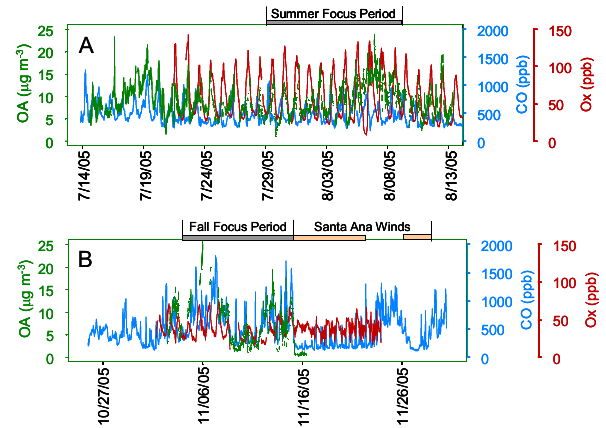
Fig. 5. AMS PM 1 organics, carbon monoxide (CO), and odd oxygen (O x ) concentrations during SOAR 2005. (A) The sum- mer period (29 July–8 August) displays regular diurnal oxidation trends. The summer focus period (outlined in grey) is consistent with the general trend of the entire summer study. (B) The fall pe- riod (4 November–14 November) is dominated by meteorological “events”, with lower O x concentrations than observed in summer. The fall focus period (outlined in grey) is representative of a period high in particulate concentrations and CO